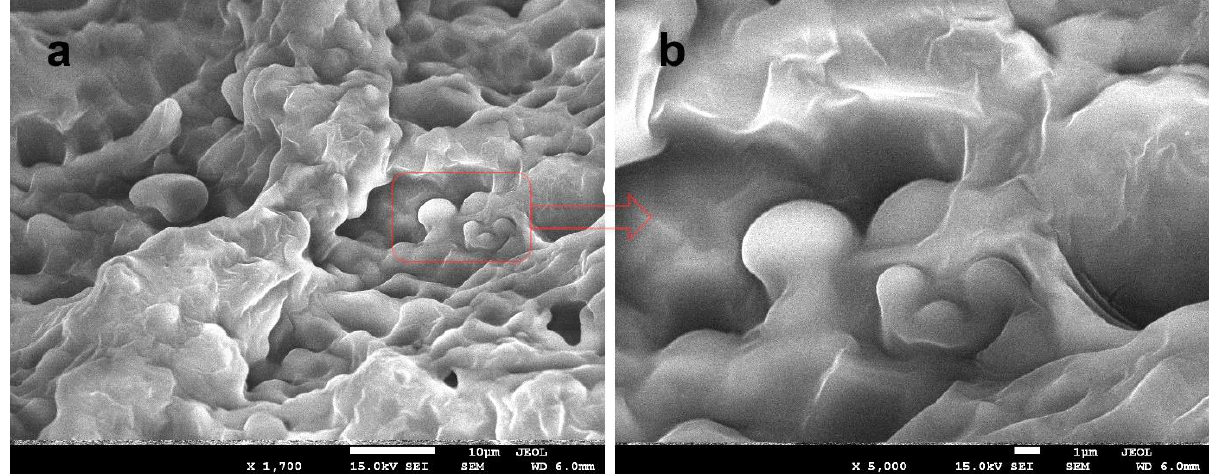
Figure 7. A SEM image of the Cur-2 composite at the magnifications of ×1700 ( a ) and ×5000 ( b ).